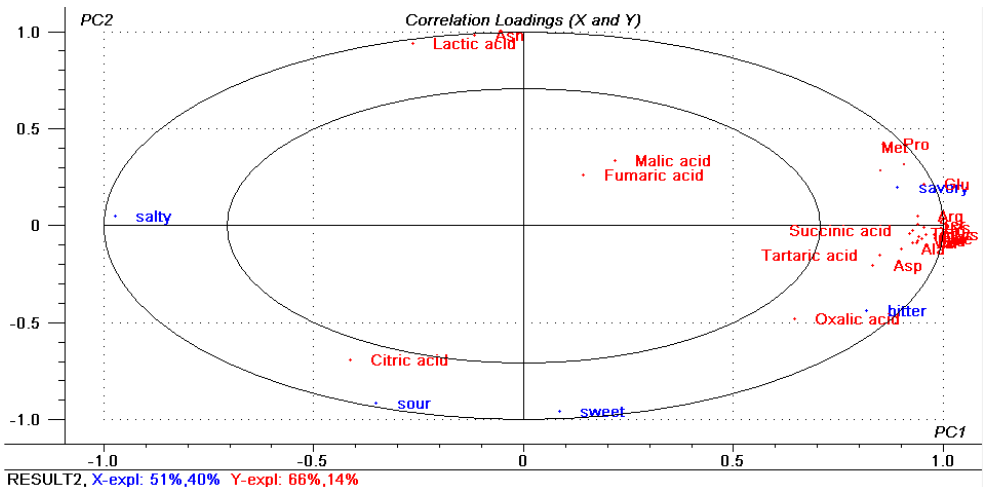
Figure 3. The overview of the variation found in the mean data from the partial least squares regression (PLSR) correlation loadings plot for Pixian broad-bean paste samples. The model was derived from sensory attributes as the X-matrix and taste-active compounds as Y-matrix. Circles represent r 2 = 0.5 and 1.0, respectively.